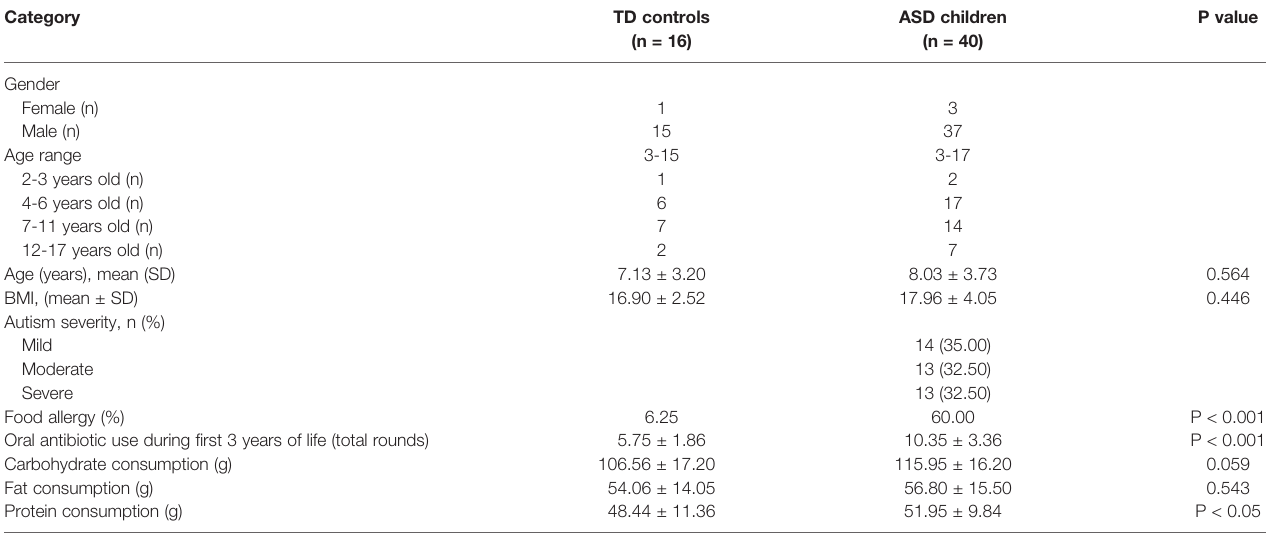
TABLE 1 | Demographic characteristics of study participants and their medical